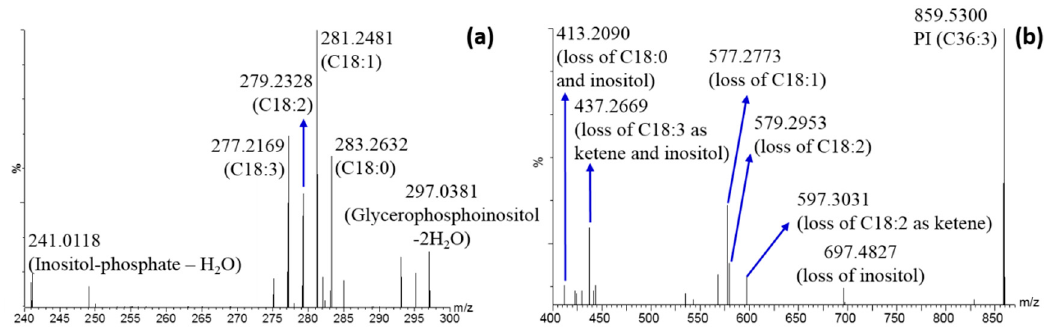
Figure 5. MS/MS spectrum of m/z 859.53 obtained in negative ionization mode at a collision energy of 30 eV: ( a ) over the range 240–300 m/z ; ( b ) over the range 400–870 m/z .